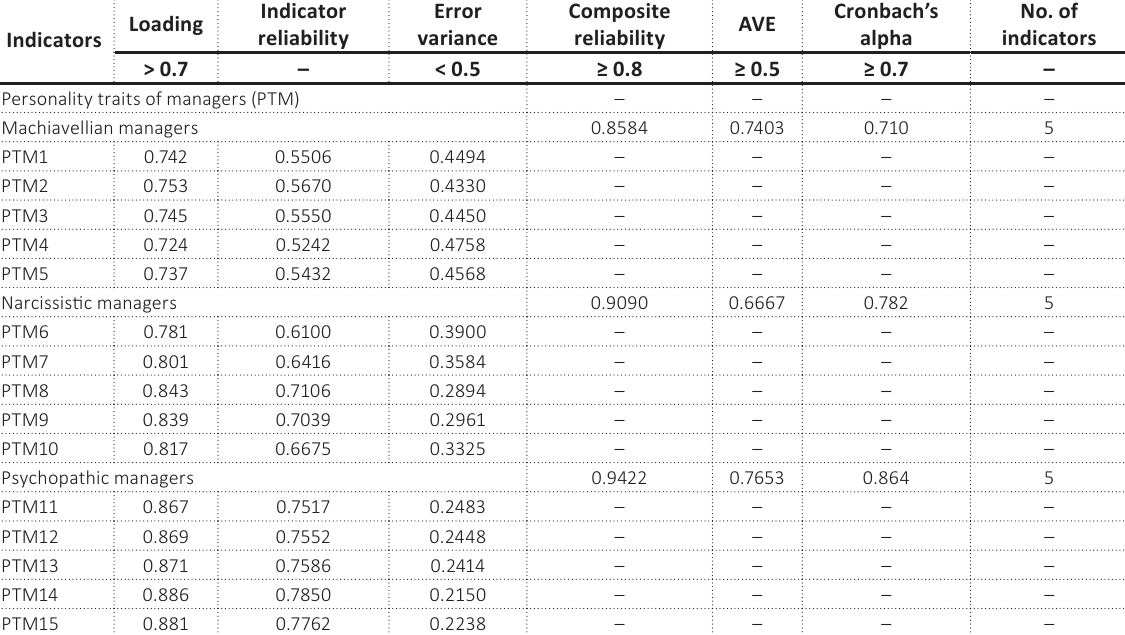
Source: Field survey